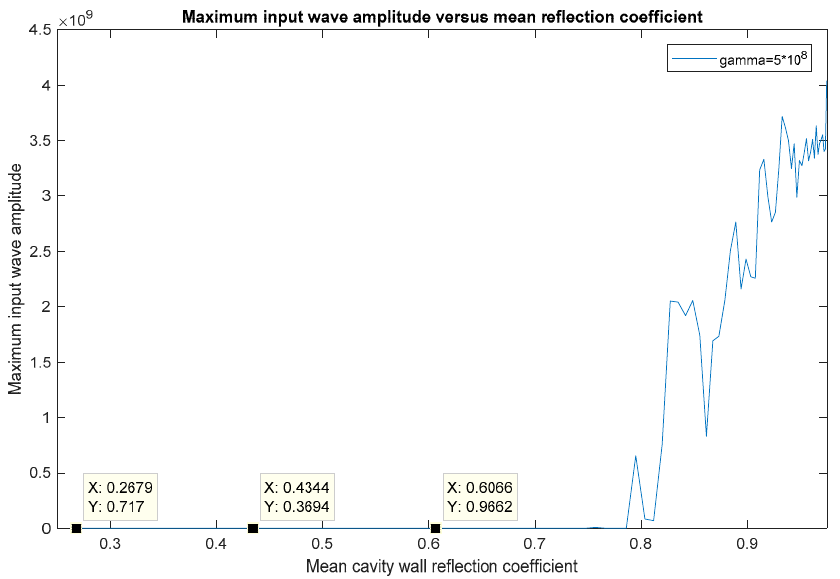
Figure 17. Maximum input wave amplitude at x = 5.73 µ m versus mean cavity wall reflection coe ffi cient for an initial pump wave amplitude of 3.75 × 10 8 V/m at f 0 = 8 × 10 14 Hz and for γ = 5 × 10 8 .